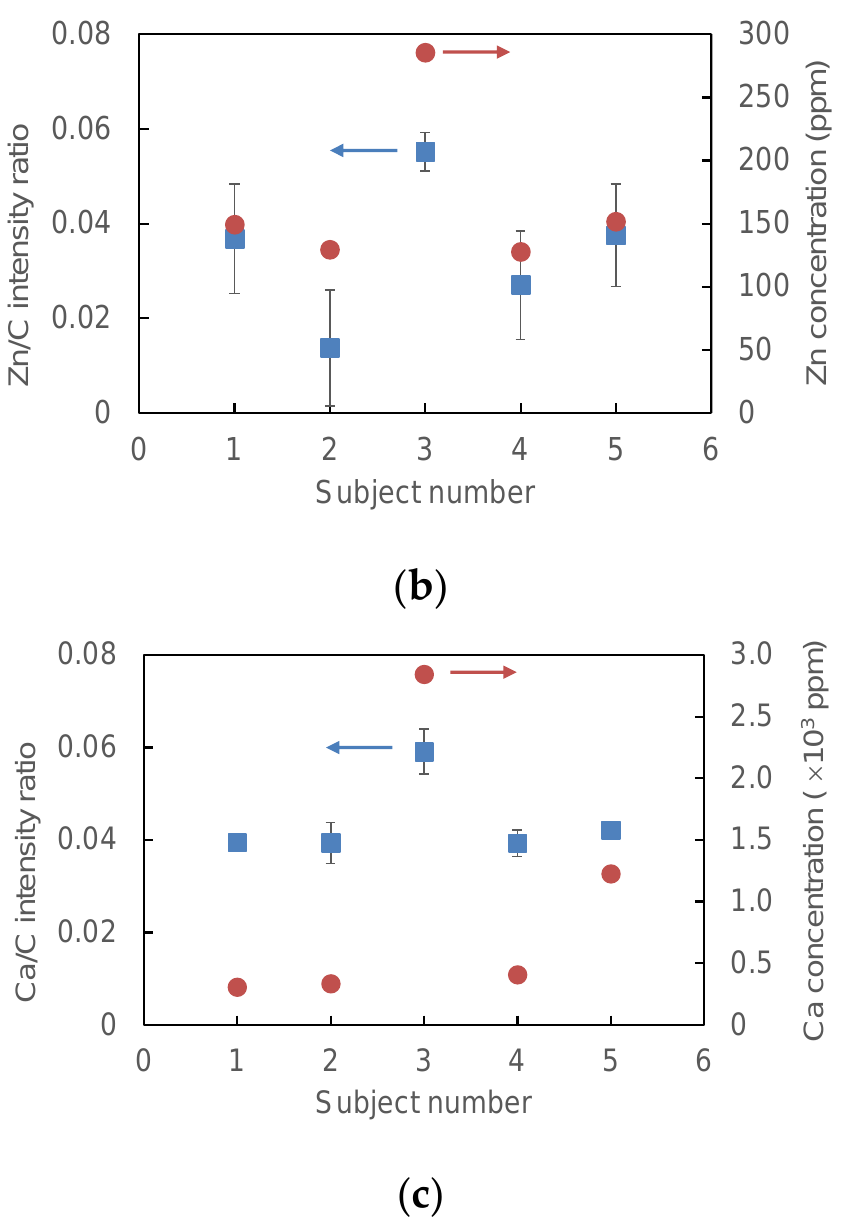
Figure 9. Relative mass concentrations of ( a ) Mg, ( b ) Zn, and ( c ) Ca measured for the five subjects and compared with the absolute concentrations analyzed via ICP-MS.